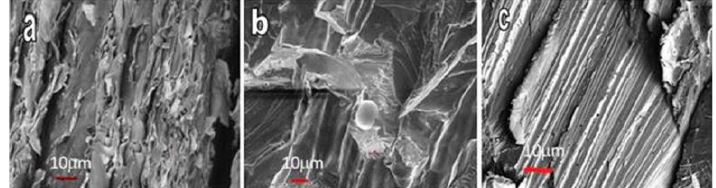
Figure 7. Fractographs of ( a ) the parent metal, ( b ) EB weld joint, and ( c ) LGTHW Joint of tensile samples. Change in the morphology and the presence of sharp faceting in samples containing weld joints could be noticed [5].